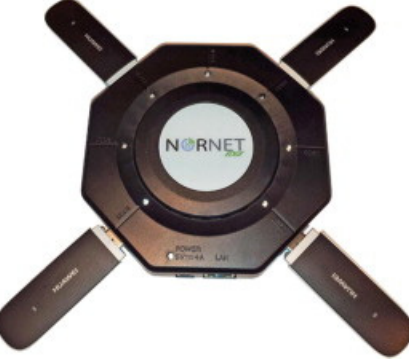
Figure 8. NNE node with 4 modems connected [52].